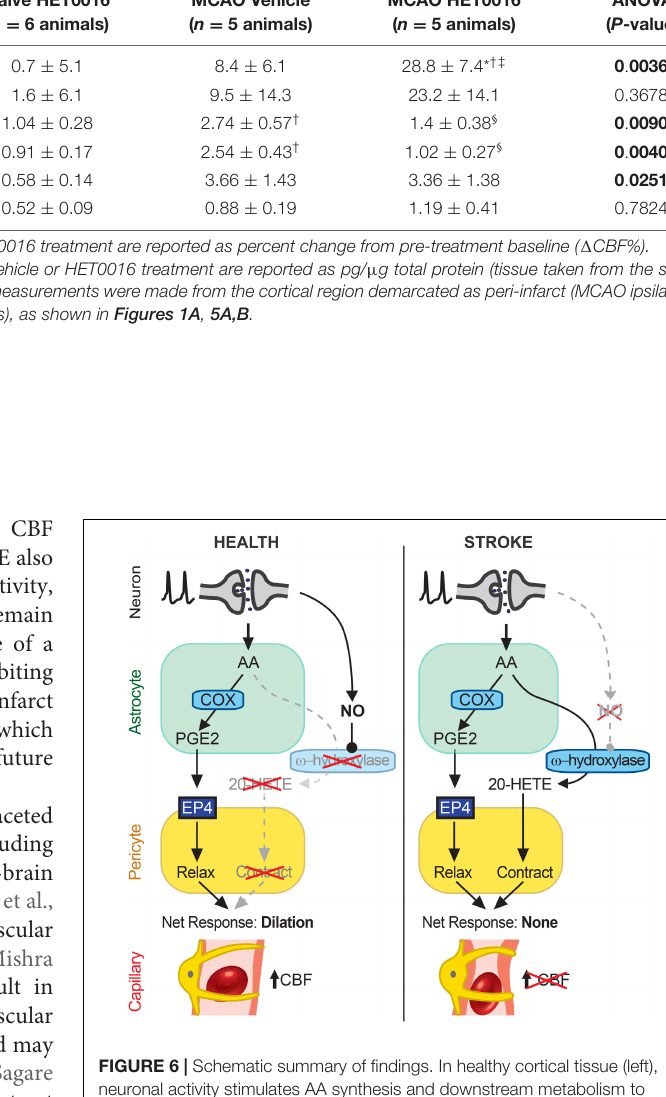
Naïve Vehicle ( n = 5 animals)